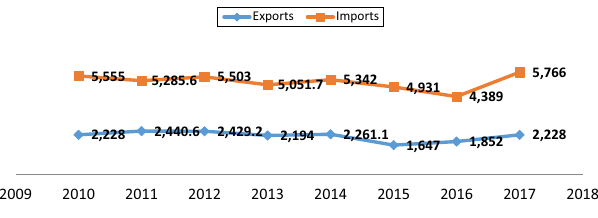
Figure 4. Egyptian exports and imports during 2010-2017 in millions of